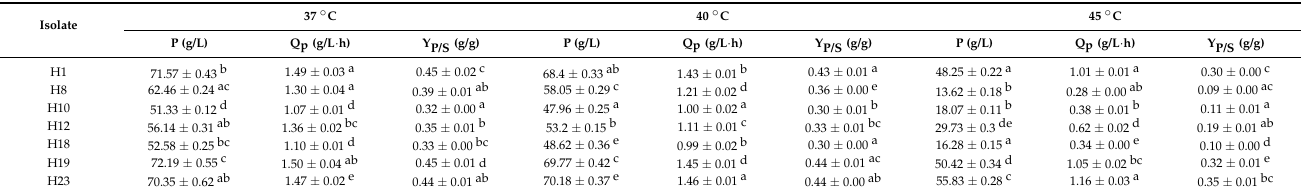
Table 1. Efficiency of bioethanol production at different temperatures by selected yeasts using glucose as sole carbon